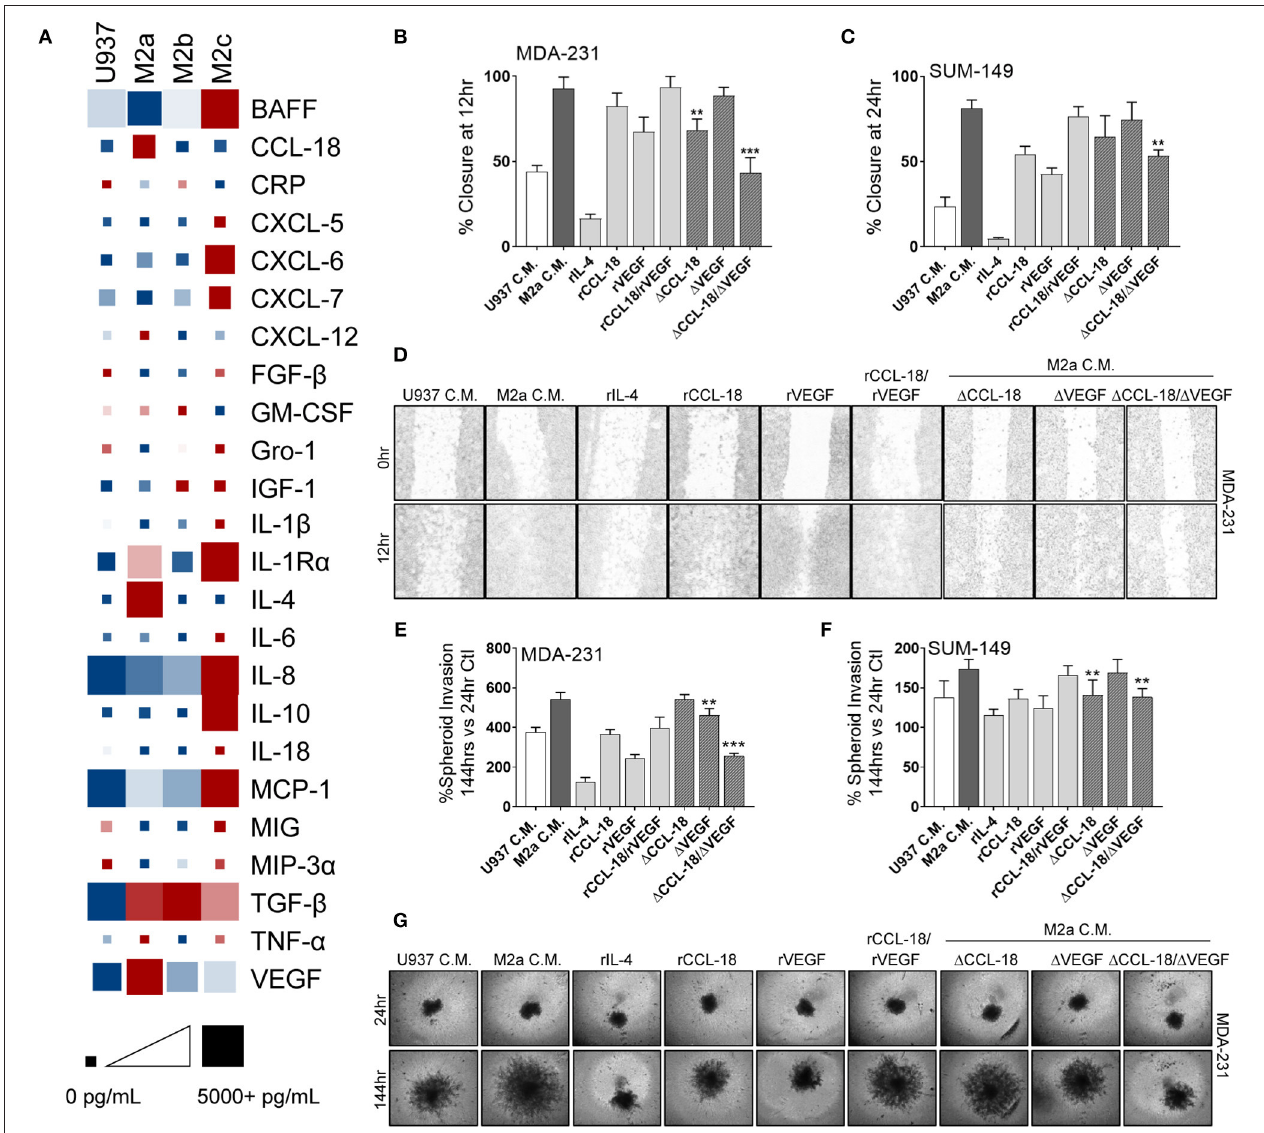
FIGURE 4 | Synergistic activity of CCL-18 and VEGF, secreted from M2a macrophages, enhance breast cancer cell migration. (A) ELISA results from concentrated cell supernatants indicate that M2a macrophages secrete higher levels of CCL-18, IL-4, and VEGF than their M2b or M2c counterparts. ELISA data is averaged across 4 independent experiments. Colors indicate row comparisons of a single analyte protein level [low levels (blue) vs. high levels (red)] compared among the macrophage populations. Square or box size is designed to provide quantitative global analysis of overall analyte protein levels e g., 1 pg/mL (small square) to 5,000 pg/mL (large square). Results from wound closure assay in MDA-MB-231 cells (B) and in SUM-149 cells (C) show removal of CCL-18 and VEGF from M2a C.M. significantly inhibits migration. (D) Representative images of MDA-MB-231 cells wound migration assays results. Similar results obtained from spheroid invasion assays in both MDA-231 (E) and SUM-149 cells (F) . Representative images from MDA-231 invasion assays shown in (G) . Data is reported as an average ± std. dev. of 3 independent experiments, analyzed by one-way ANOVA, ** p > 0.01, *** p >